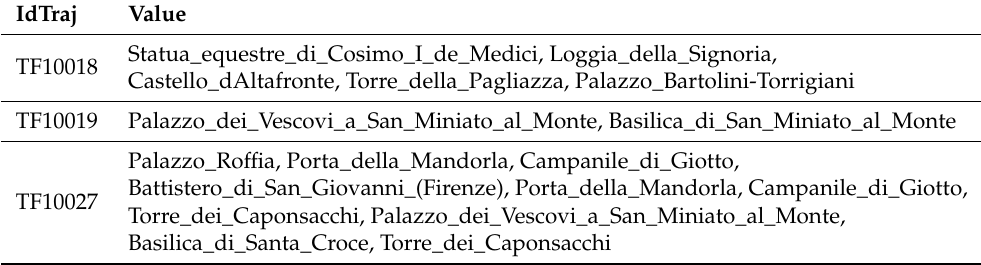
Table 13. Example of POIs name trajectory.